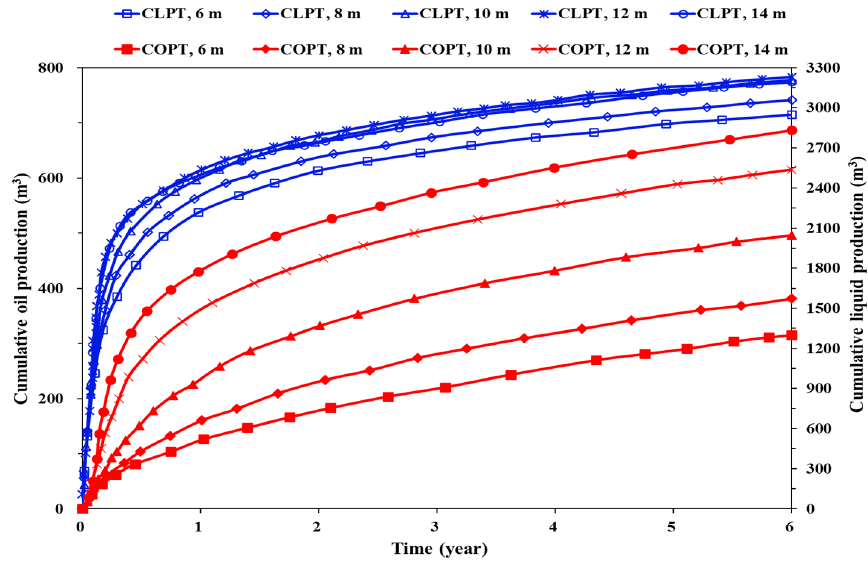
Figure 18. Production performance curves with different interlayer thickness values (6 years of